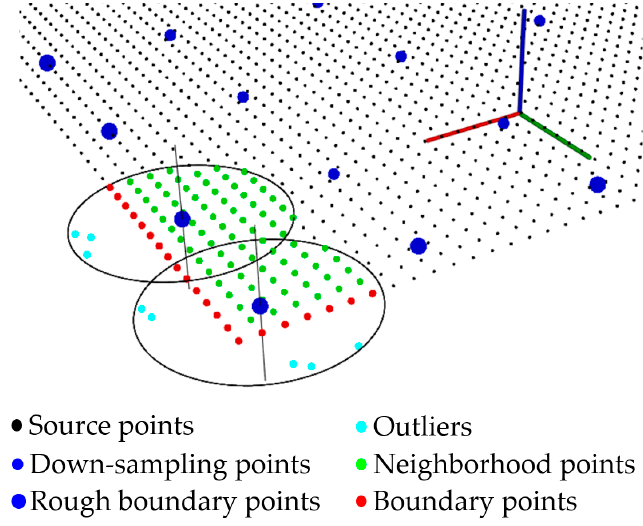
Figure 3. Result of the optimized boundary extraction method. The down-sampling points are first obtained to identify the rough boundary points, and then, we search for the accurate boundary points and eliminate the outliers based on the neighborhood points of the approximate boundary